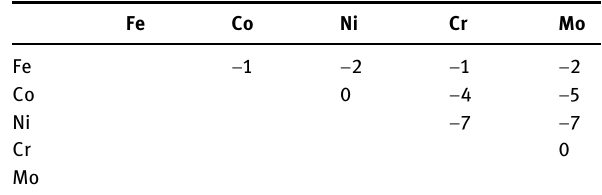
Table 4: The values of H Δ ABmix ( kJ mol − 1 ) calculated by Miedema ’